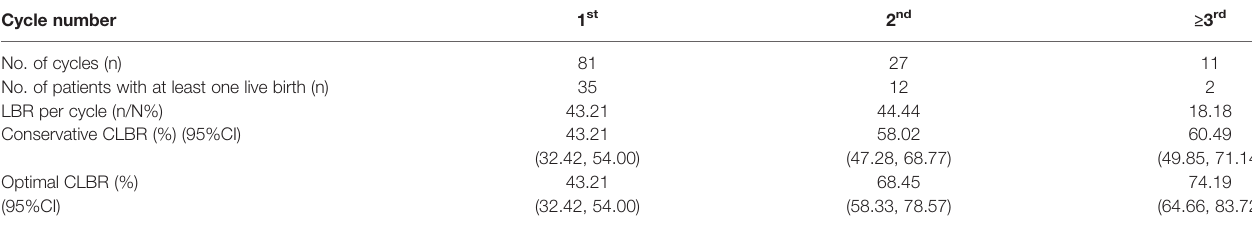
TABLE 4 | The cumulative live birth rates (CLBRs) over multiple complete IVF cycles of HH